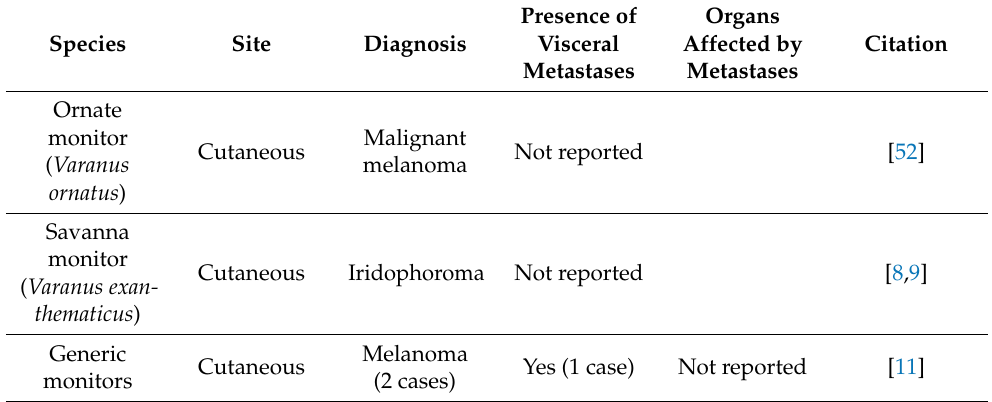
Table 6. Clinical features of chromatophoromas in the reptile family: Varanidae .